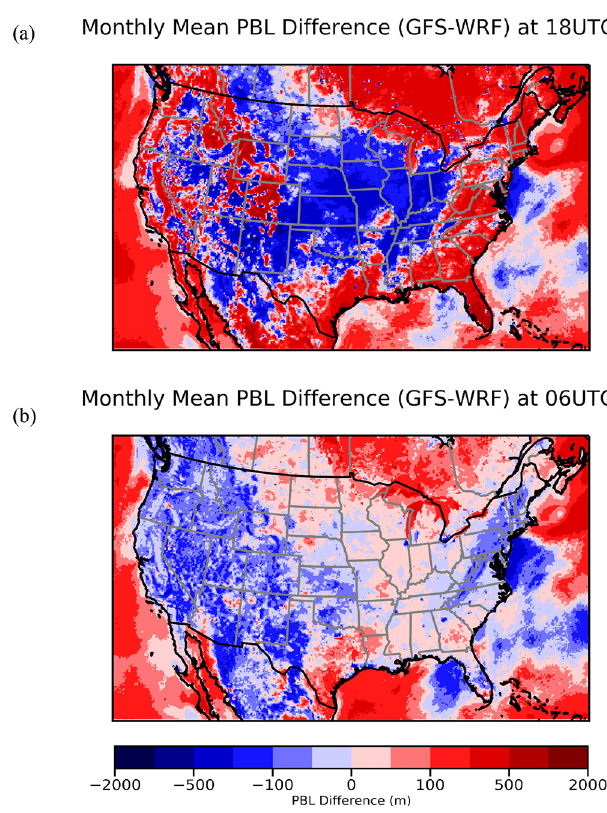
Figure 2. Monthly mean PBL height difference (GFS − WRF) for daytime (a) and nighttime (b) in August